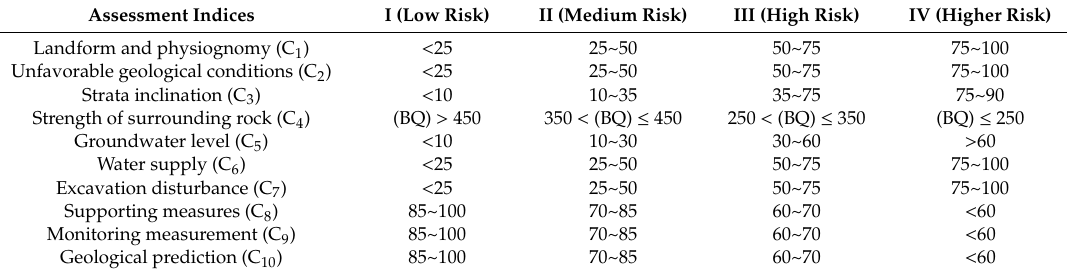
Table 1. Assessment indices and classification criteria for water